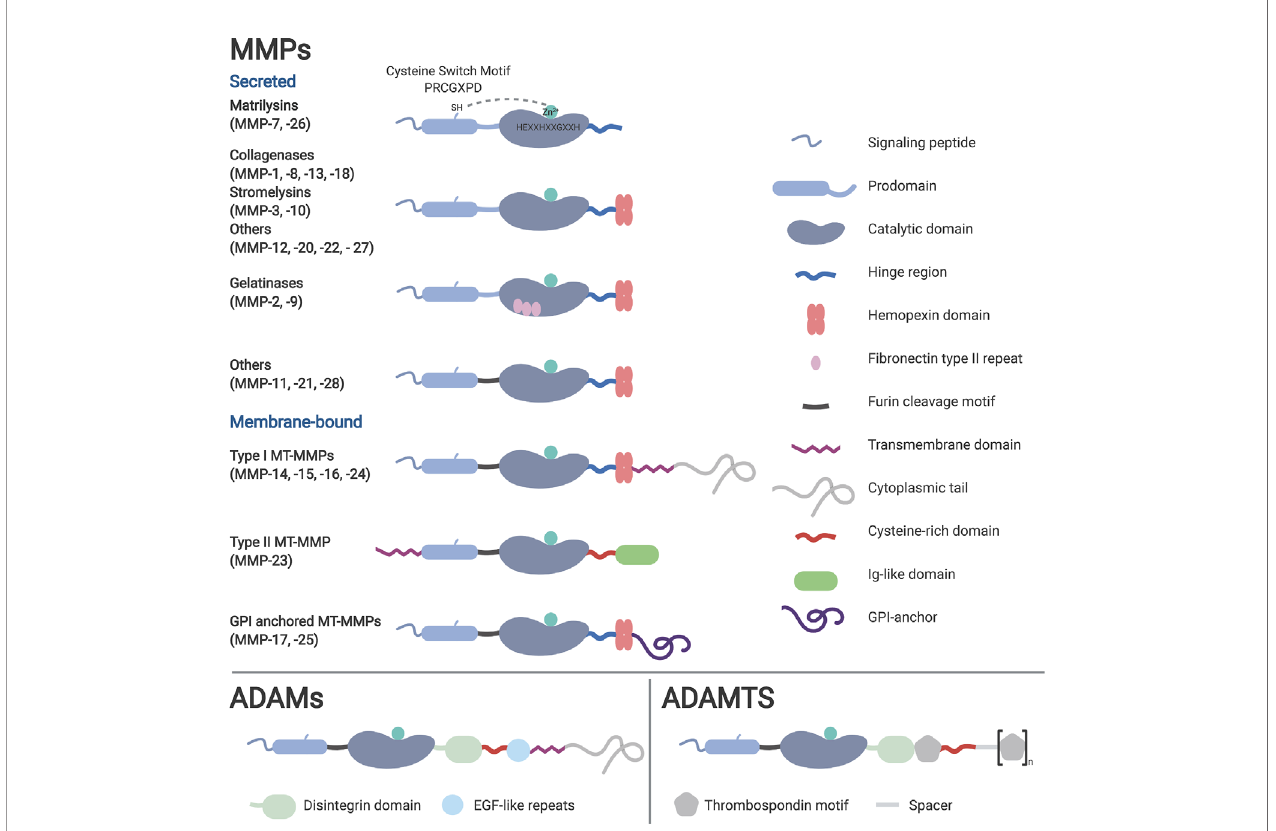
FIGURE 1 | Classi fi cation of the metzincins based on their structure and function. Typical for metzincins is their signal peptide, the prodomain, the catalytic domain containing the zinc motif, followed by the linker (hinge) region. Membrane-associated metalloproteinases typically harbor a transmembrane and cytosolic domain, lacking in the secreted family members. Depending on their mode of activation, several metalloproteinases have a furin recognition sequence. Distinctive for many MMPs is the hemopexin (PEX) domain, which facilitates substrate speci fi city and TIMP